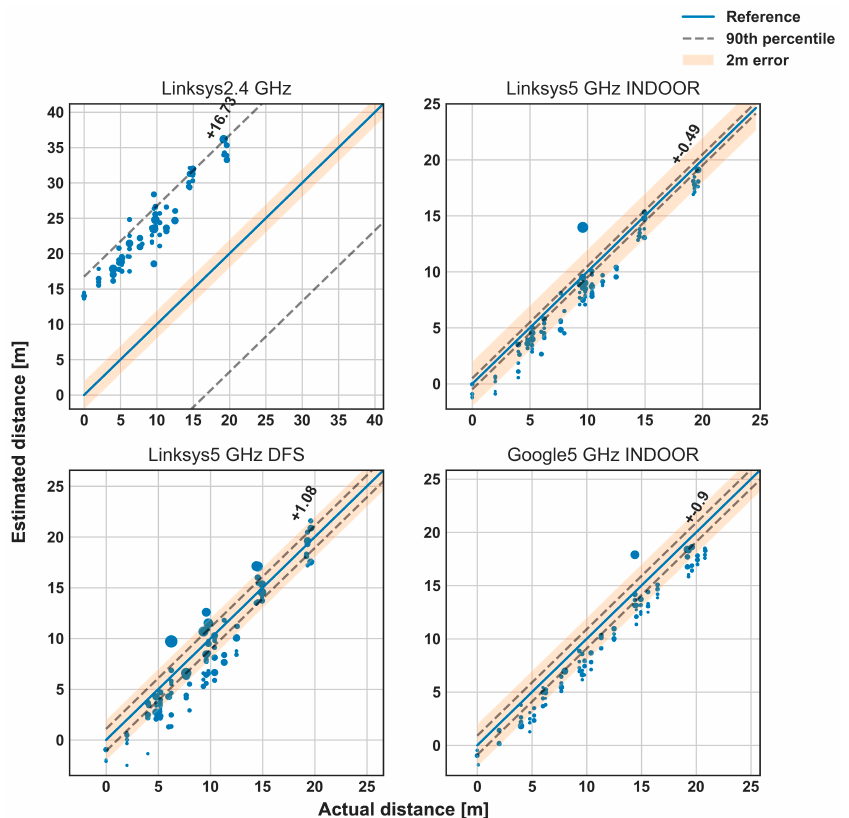
Figure 6. Estimated distance versus actual distance (in meters). The bigger the marker, the higher the standard deviation of the error. The 90th percentile is displayed with the dash-gray line, while the 2-m error in yellow.